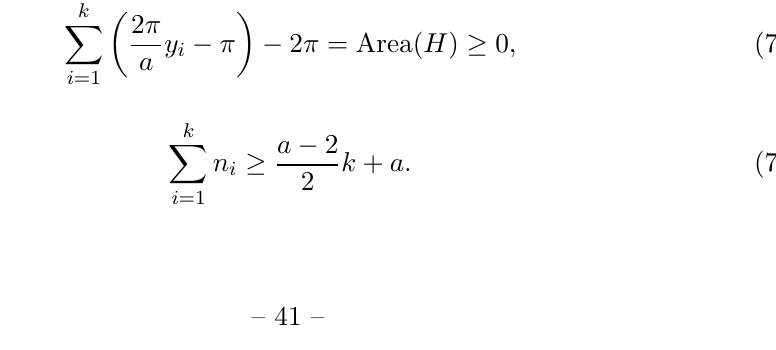
Figure 27 . The \directed sum" of two directed cuts C A (purple) and C (cid:22) directed closed curves C I (green) and C 0 in